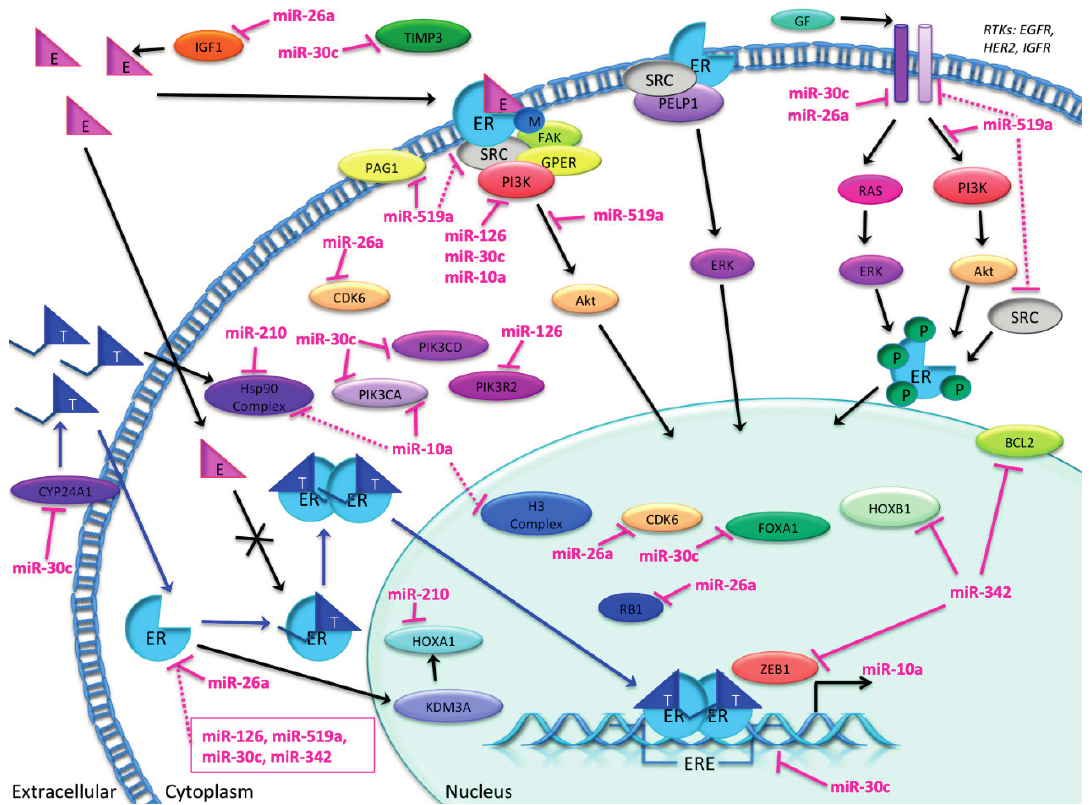
Figure 7. Overview of the possible involvement of candidate microRNAs in tamoxifen resistance pathways, based on the present literature search and IPA analysis. MicroRNAs miR-10a, -26a, -30c, -126, -210, -342-5p and -519a and their direct (pink lines) or indirect (dotted lines) targets. BCL2: B-cell CLL/lymphoma 2; CDK6: cyclin-dependent kinase 6; CYP24A1: cytochrome P450, family 24, subfamily A, polypeptide 1; IGF1: insulin-like growth factor 1; FOXA1: forkhead box A1; HOXA1: homeobox A1; HOXB1: homeobox B1; Hsp90: heat-shock protein 90. KDM3A: lysine (K)-specific demethylase 3A. PAG1: phosphoprotein membrane anchor with glycosphingolipid microdomains 1; PI3K: phosphoinositide 3-kinase; PIK3CA: phosphatidylinositol-4,5-bisphosphate 3-kinase, catalytic subunit alpha; PIK3CD: phosphatidylinositol-4,5-bisphosphate 3-kinase, catalytic subunit delta; PIK3R2: phosphoinositide-3-kinase, regulatory subunit 2 (beta); RB1: retinoblastoma 1; TIMP3: TIMP metallopeptidase inhibitor 3; ZEB1: zinc finger E-box binding homeobox 1. Black arrow: normal pathway. Blue arrow: tamoxifen pathway. Crossed arrow: disrupted pathway. Pink inhibition arrow: direct inhibition by miRNA. Dotted pink inhibition arrow: indirect inhibition by